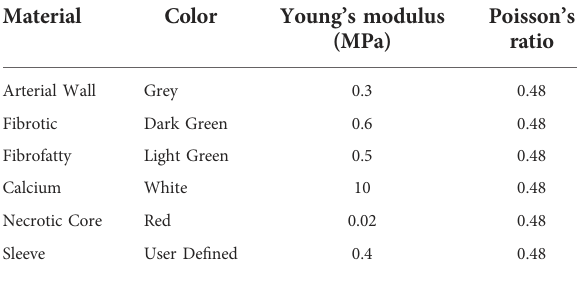
TABLE 1 Material properties used for FEA. VH-IVUS color, associated Young ’ s modulus (MPa), and Poisson ’ s ratio for each material type used in the FEA simulations